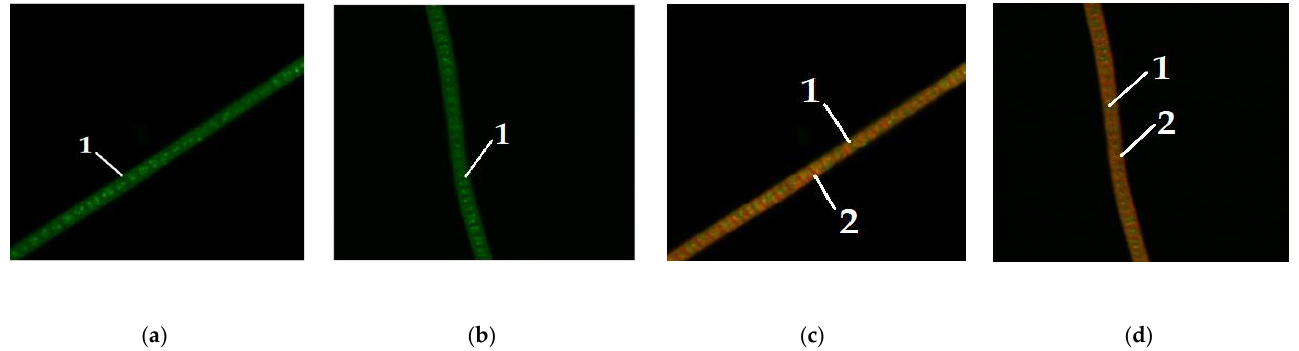
Figure 4. Microalgae Arthrospira platensis without the addition of carbohydrates to nutrient media (1 – lipid droplet, 2 – chlorophyll): ( a , b ) visualization of lipids; ( c , d ) visualization of chlorophyll. Figure 5 depicts the dye staining of lipids in microalgae Arthrospira platensis when glucose is added to the nutrient media.